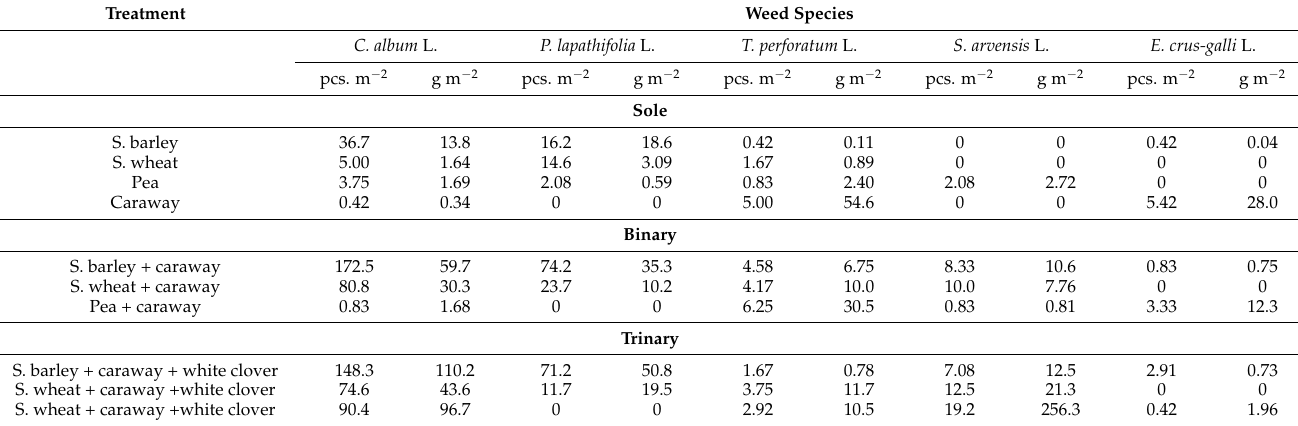
Table 2. The average number and the average biomass of dominant weed species in sole, binary, and trinary crops in 2017. Treatment Weed Species